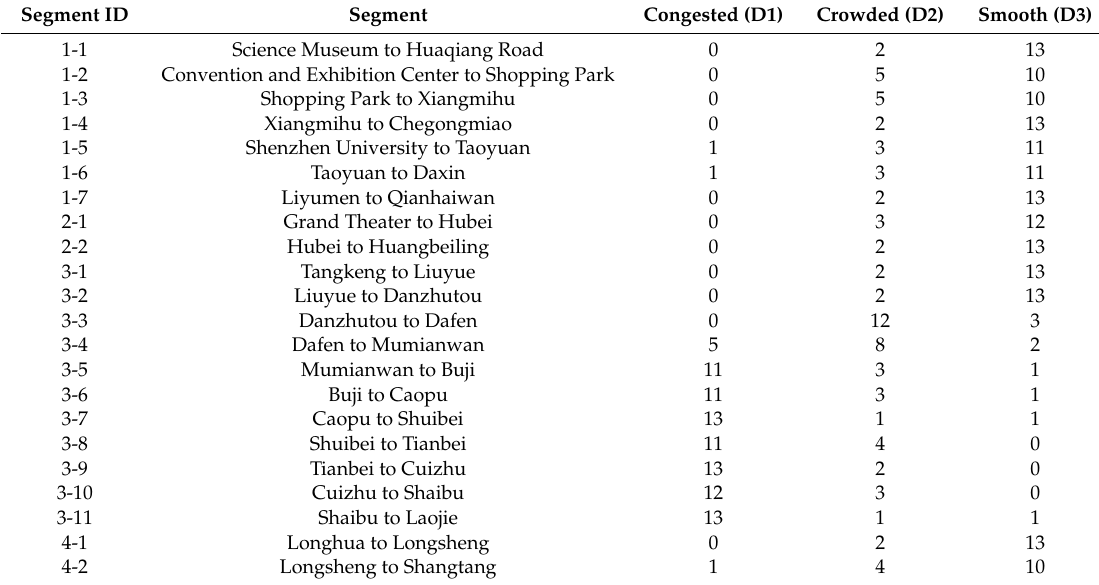
Figure A1. Diagram showing congestion during the morning peak hours on 12 May 2017. Green: smooth, Orange: crowded, Red: congested. Table A1. Statistical congestion